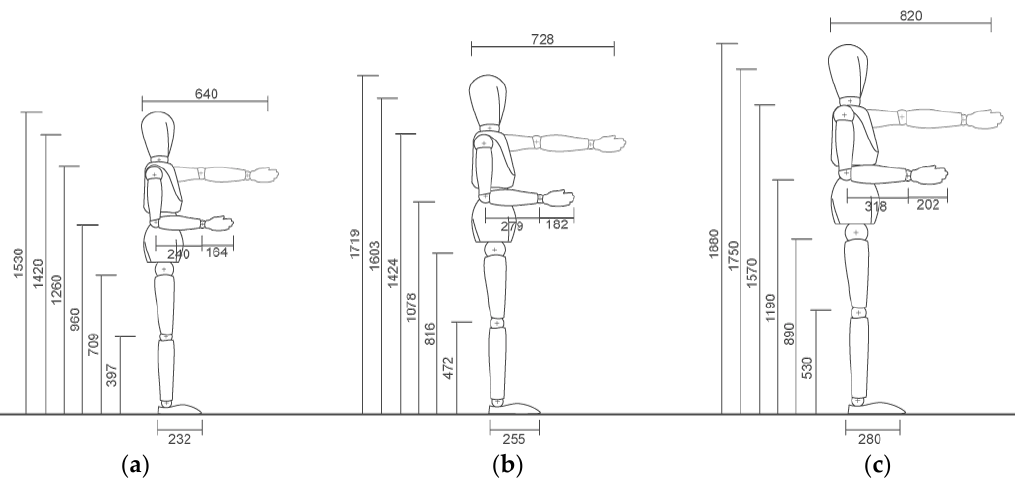
Figure 4. Human figure representations based on European anthropometric data [37] considering the ten variables of interest: ( a ) 5th percentile, ( b ) 50th percentile, and ( c ) 95th percentile.